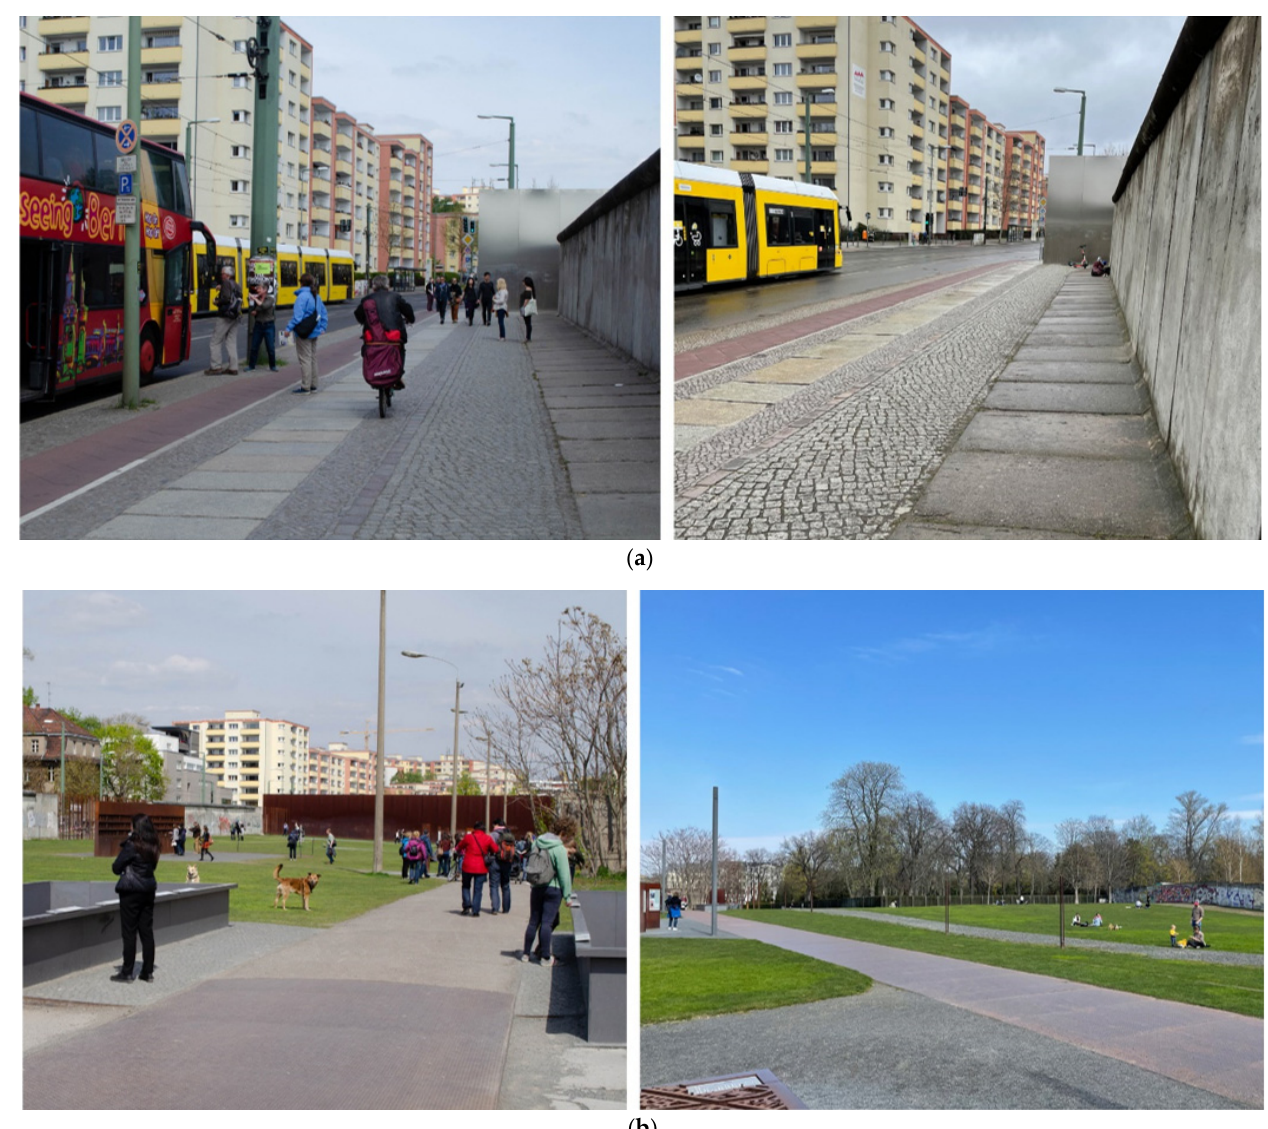
Figure 2. Images taken of the Berlin Wall Memorial in 2017 and 2021. ( a ) The Berlin Wall Memorial on the west side of the memorial core along Bernauer Strasse during pre-pandemic (left) and mid-pandemic (right) observations (Left image Pamela Jordan; right image André Fiebig); ( b ) The Berlin Wall Memorial in the southern death strip interpretive territory of pre-pandemic (left) and mid-pandemic (right) observations. The historic patrol road is in the center of each image (Left image Pamela Jordan; right image André Fiebig).